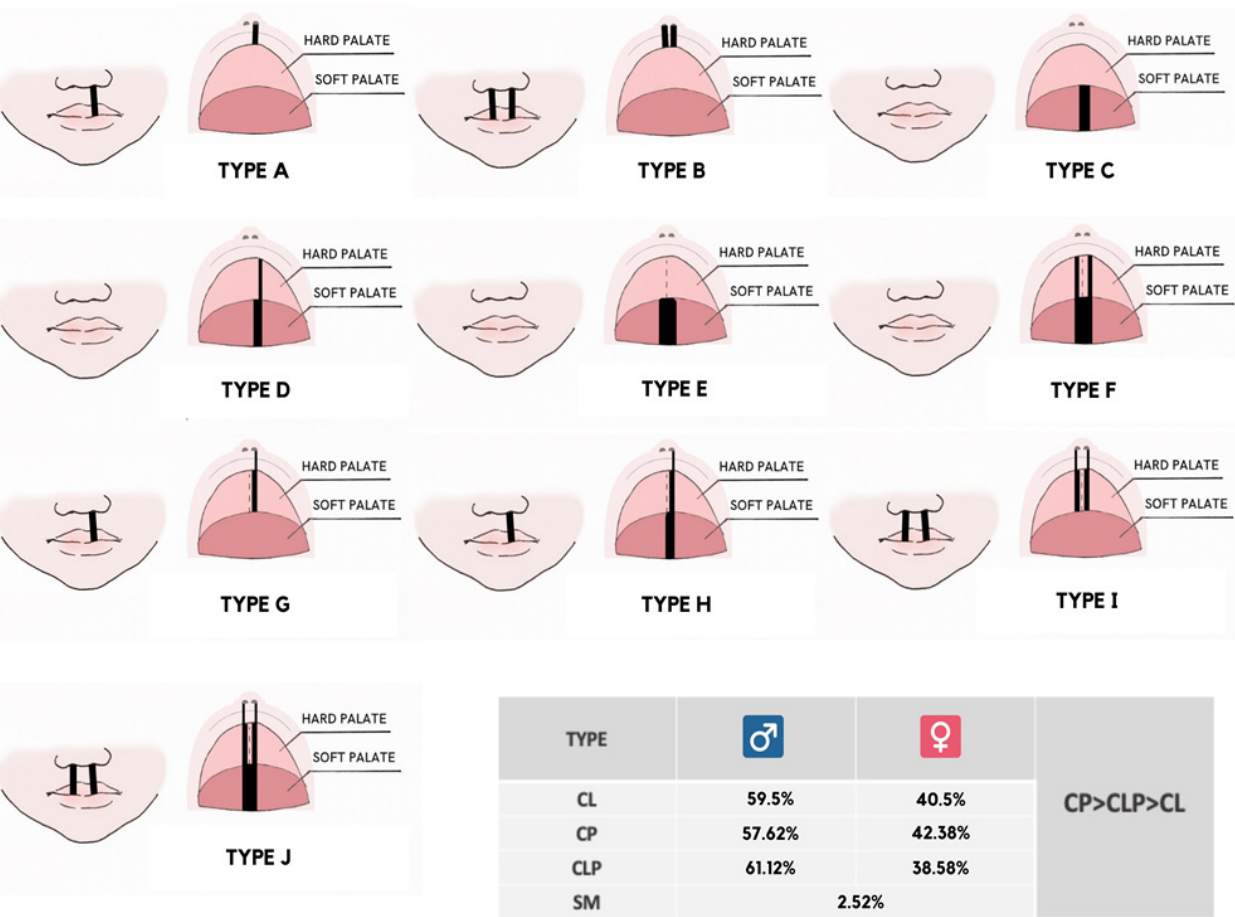
Figure 1. Anatomical classification of OFCs [CL: cleft lip; CLP: cleft lip and palate; CP: cleft palate]. Type A and type B: CL (mono and bilateral); type C and type E: soft CP (mono and bilateral); type D and type F: soft and hard CP (mono and bilateral); type G and type I: hard CLP (mono and bilateral); type H and type J: soft and hard CLP (mono and bilateral).